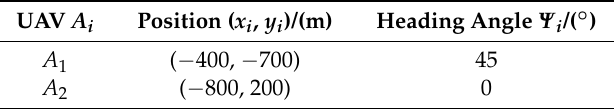
Table 2. The initial settings of two UAVs in Scenario 1.